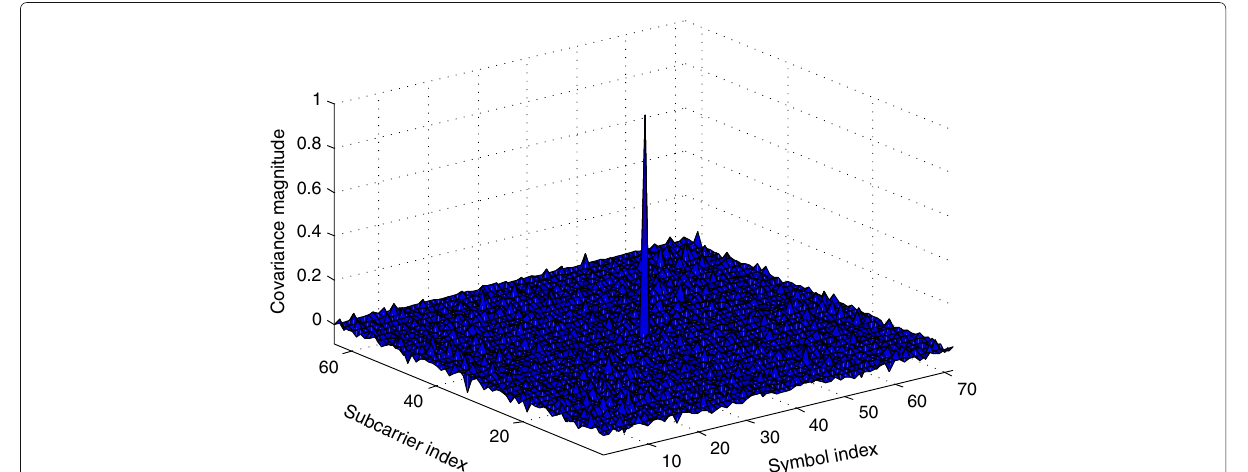
Fig. 9 Covariance of data interference at a pilot location with data interference in other pilot locations